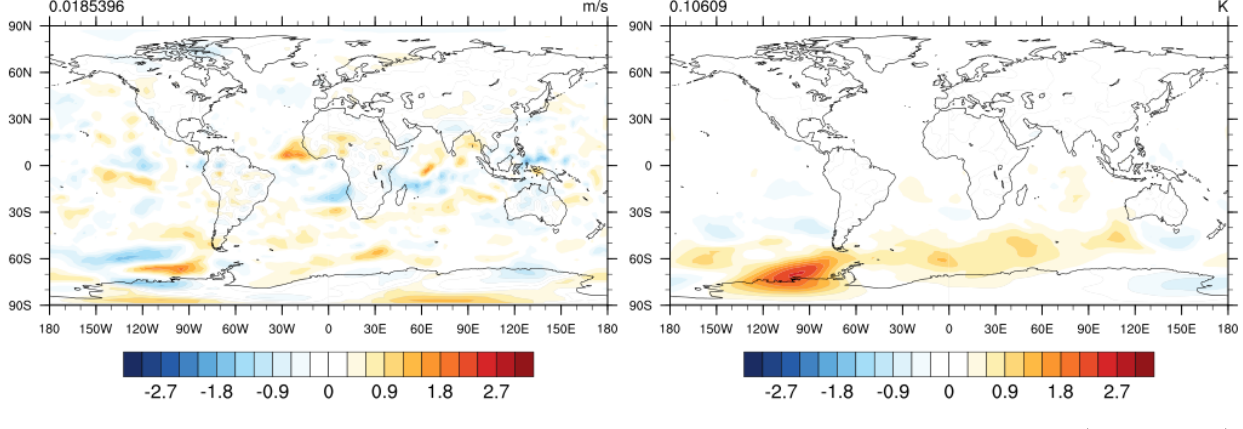
Figure 10. Improvement of EXP_RO analysis from CTRL_SONDE, toward ERA interim, computed by the equation (cid:12) (cid:12) − 1 ) and T (right, unit: K) at the level of 100hPa. Positive values indicate analysis of EXP_RO closer to (cid:12) for U (left, unit: ms (cid:12) x a ro − ERA ERA interim data than CTRL_SONDE and vice versa. Global mean values are present at the top left of each figure.